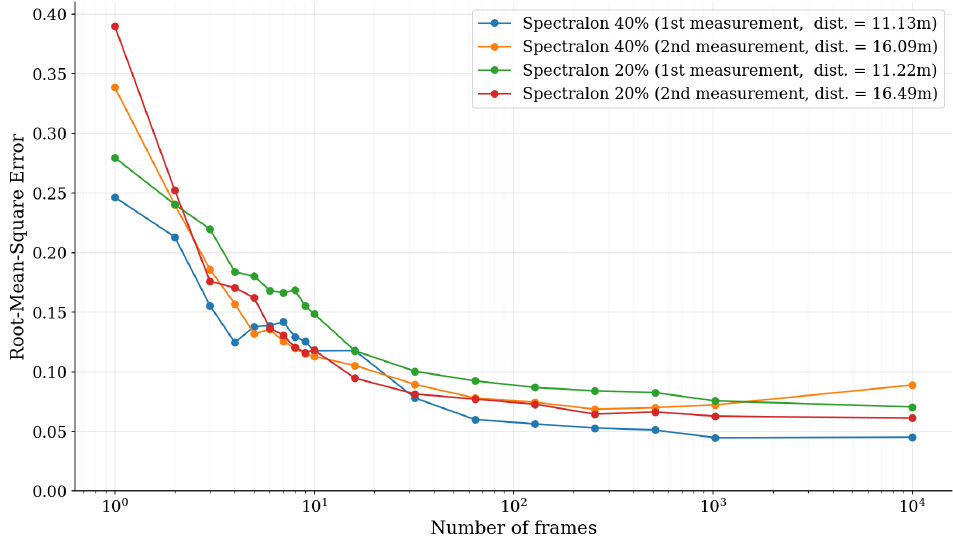
Figure 12. Root-Mean-Square Error (RMSE) between the relative reflectance spectra of Spectralon measurements and an ideal (“flat”) white balance spectrum as a function of the block size N frames .